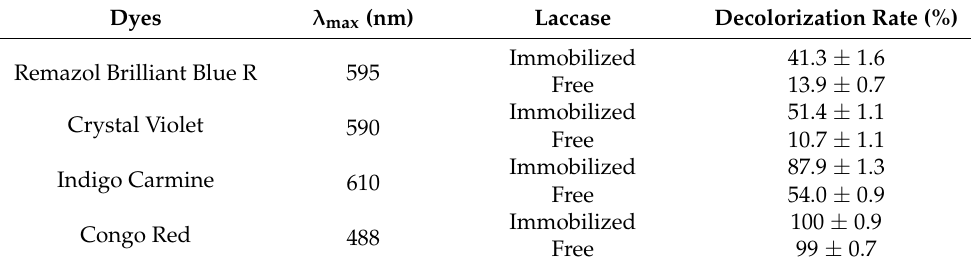
Table 5. Decolorization of various synthetic dyes by immobilized Melac13220.